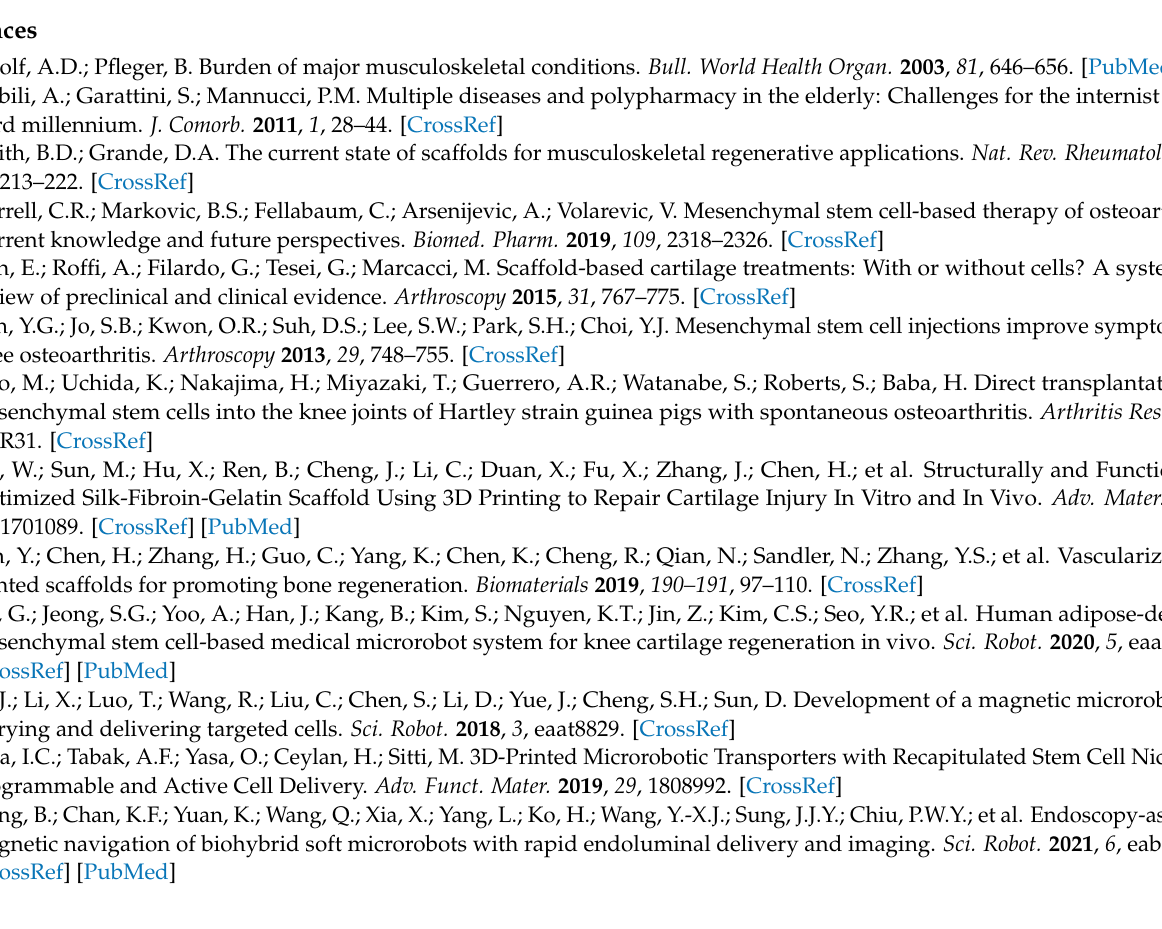
magnetic fields. The black arrows indicate the direction of the magnetic fields; Figure S4: Exper- imental setup for the magnetic actuation of the microscaffolds; Figure S5: Time-lapse images for mobility of MAM-CR and MAM-SBR at different magnetic fields (40 and 60 mT) and gradients (0.3 and 0.9 T/m). The red arrows indicate the moving distances of the microscaffolds for one second. The scale bars are 5 mm. The blue boxes in MAM-CR are shown as insets. The scale bar of the inset images is 1